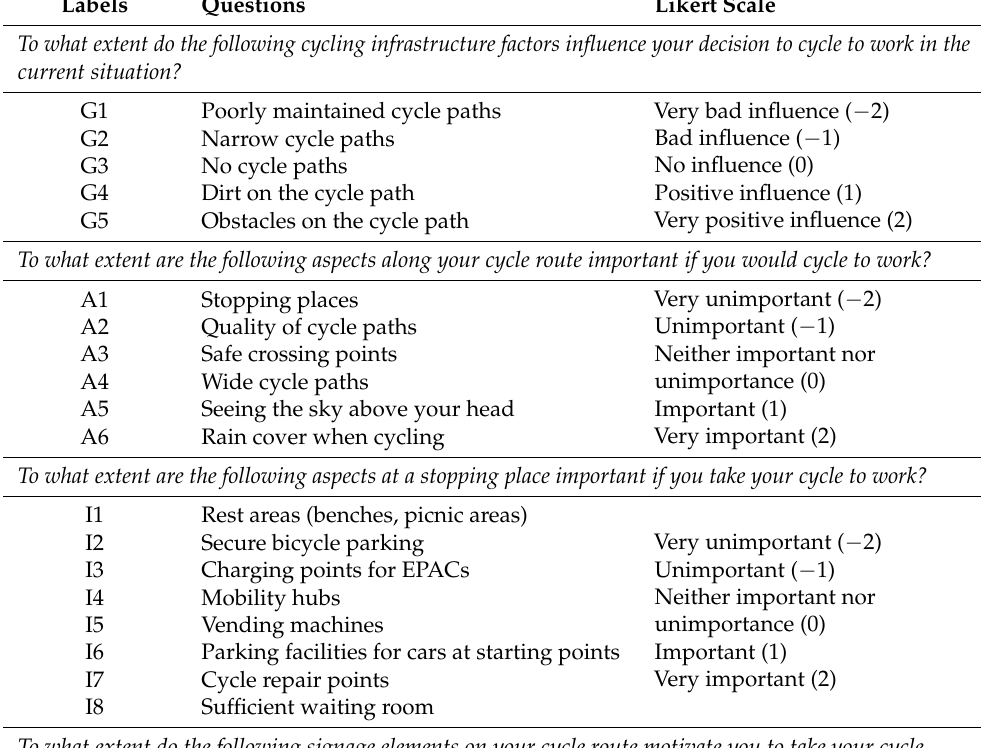
Table A1. Questions of survey with Likert